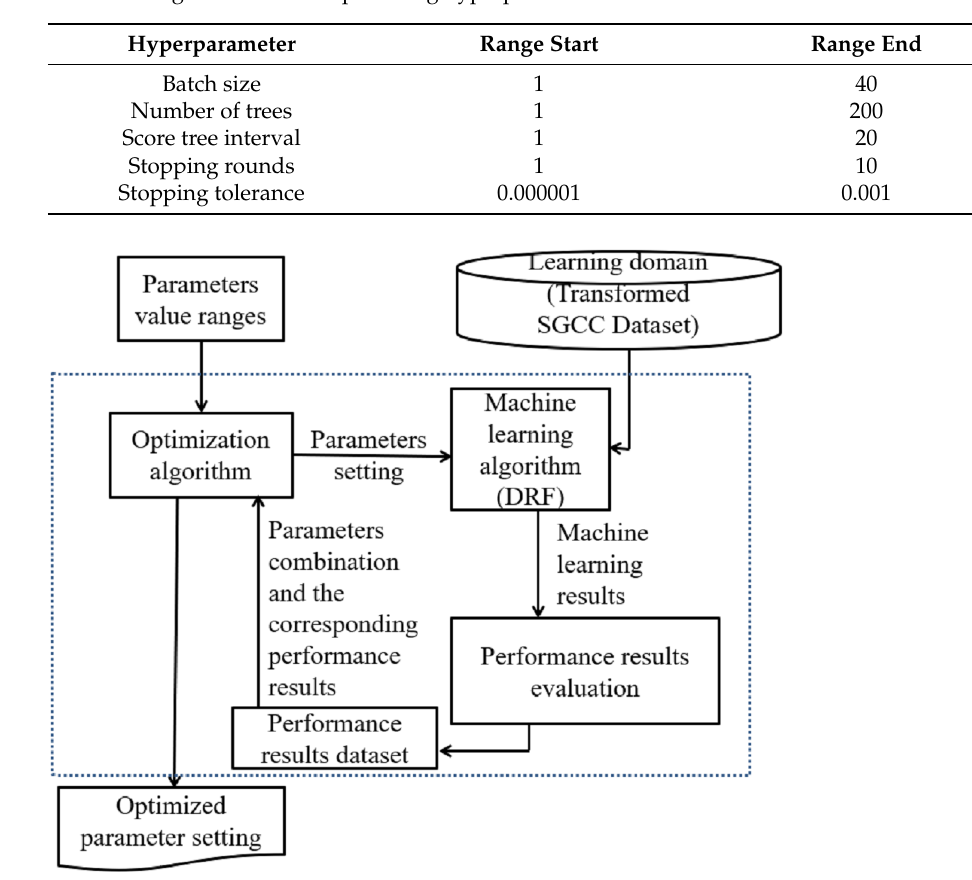
Table 2. Range of values for optimizing hyperparameters.